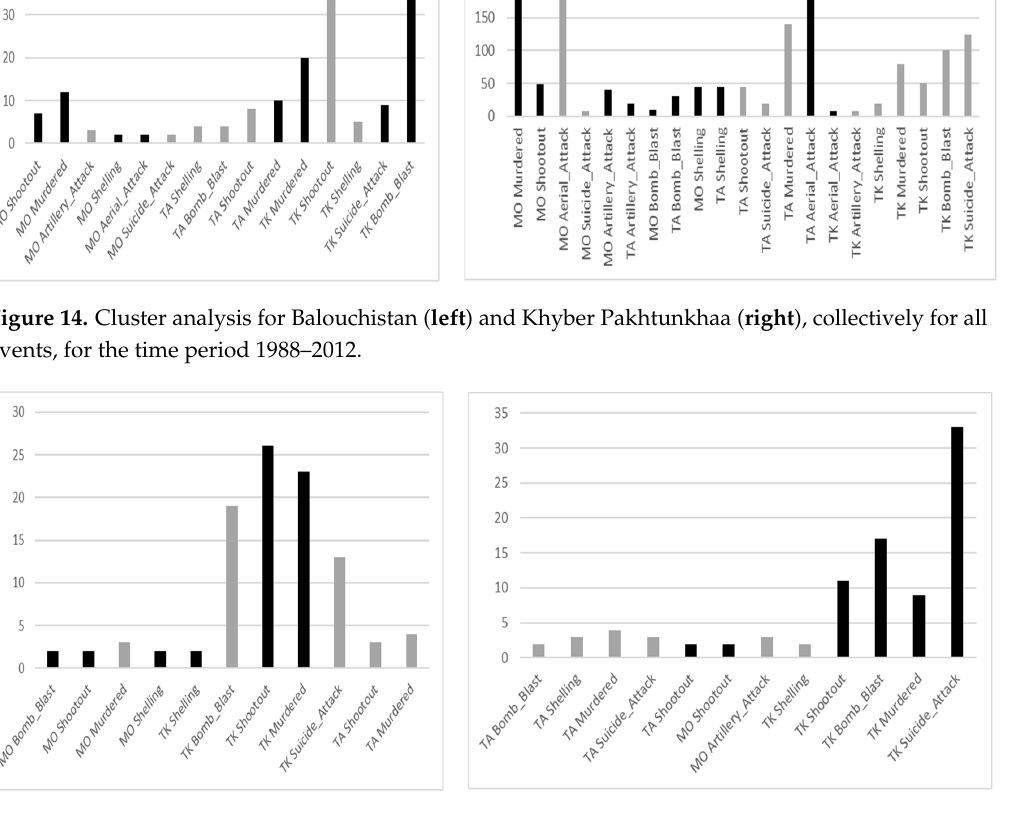
Figure 15. Cluster analysis for Punjab ( left ) and Sindh ( right ), collectively for all events, for the time period 1988–2012.